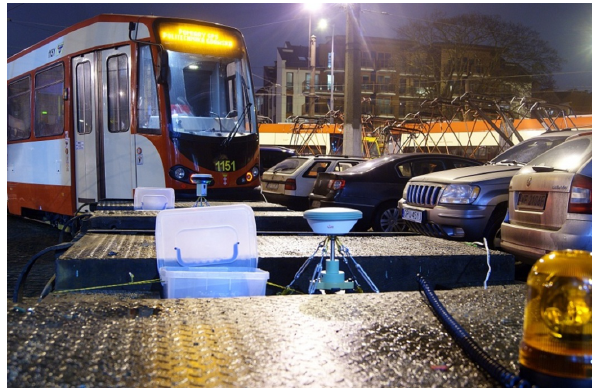
Figure 2: Measuring set with Leica Viva GS-15 and GS-12 receivers mounted on a tram bogie (photo by Jacek Szmaglinski).